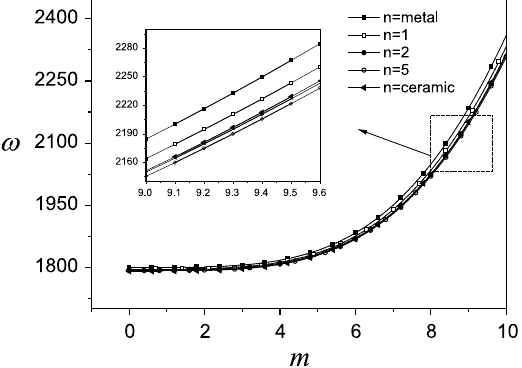
Fig. 11. The effect of volume fraction index n on each order natural frequency ω for the simply supported FGPM cylindrical shell.